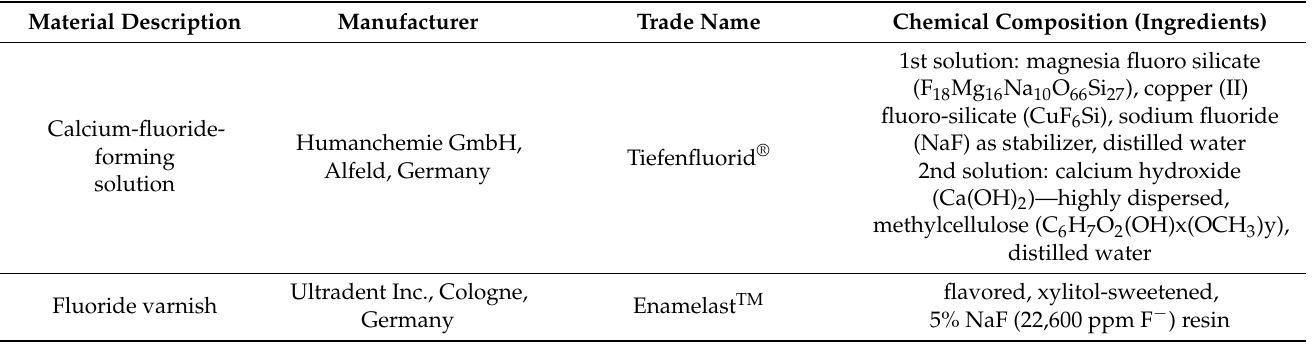
Table 1. Characteristics of the two fluoride-based agents.